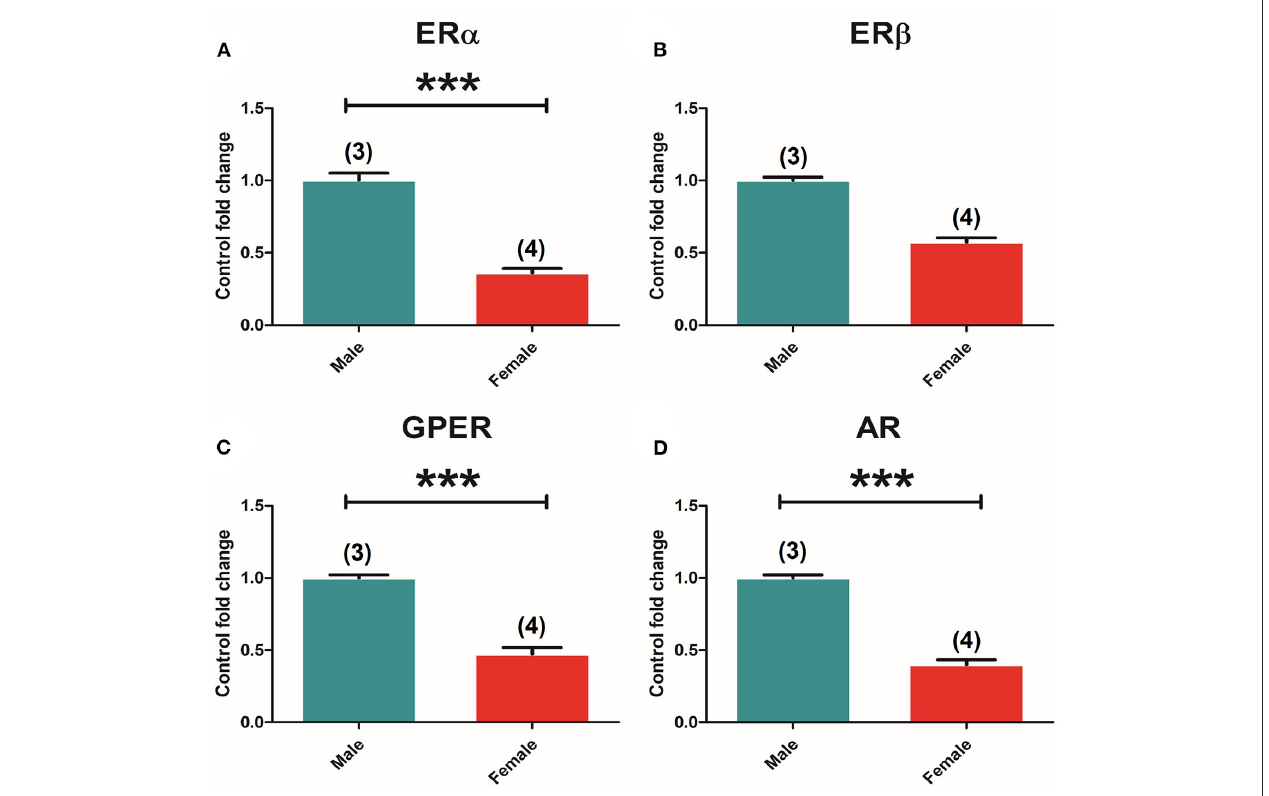
FIGURE 6 | Sexual differences in ER and AR expression in the adrenal gland. (A) ER α mRNA levels. (B) ER β mRNA levels. (C) GPER mRNA levels. Male animals ( n = 3) and female animals ( n = 4). (D) AR mRNA levels in male and female animals. Data are represented as mean ± SEM. *, ***Significant differences (* p < 0.05, *** p < 0.001) vs. male control